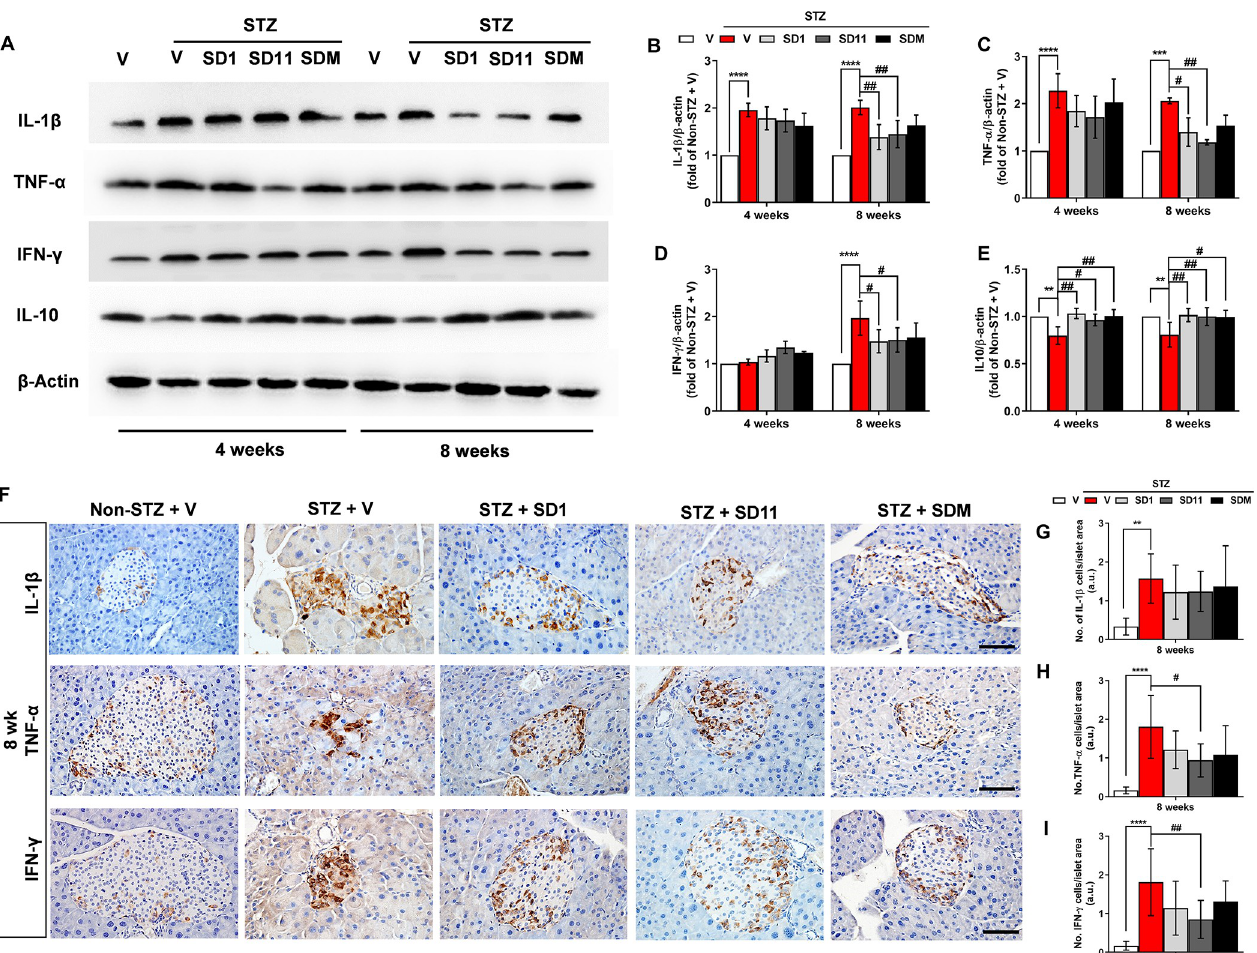
Fig 4. Probiotics attenuate MLDS-induced cytokine expression in the pancreas of mice. (A) Representative images of Western blot analysis of pancreatic cytokines IL-1 β , TNF- α , IFN- γ , and anti-inflammatory IL-10. Densitometry quantification of (B) IL-1 β , (C) TNF- α , (D) IFN- γ , and (E) IL-10 corrected by β - actin. (F) Representative images of the pancreatic tissues from different groups depict the localizations of IL-1 β , TNF- α , and IFN- γ in the islets by immunohistochemical staining, at 400 magnification. Scale bars, 50 μ m. Quantification of (G) IL-1 β , (H) TNF- α , and (I) IFN- γ . Data are presented as means ± SEM. N = 3 per group for Western blot. A measurement of approximately 50 independent islets per group (10 islets per mouse pancreas were randomly chosen from 5 animals per group) were examined for immunostaining. **** P < 0.0001, ** P < 0.01 vs. the corresponding non-STZ group; ## P < 0.01, # P < 0.05 vs. the corresponding vehicle-treated STZ